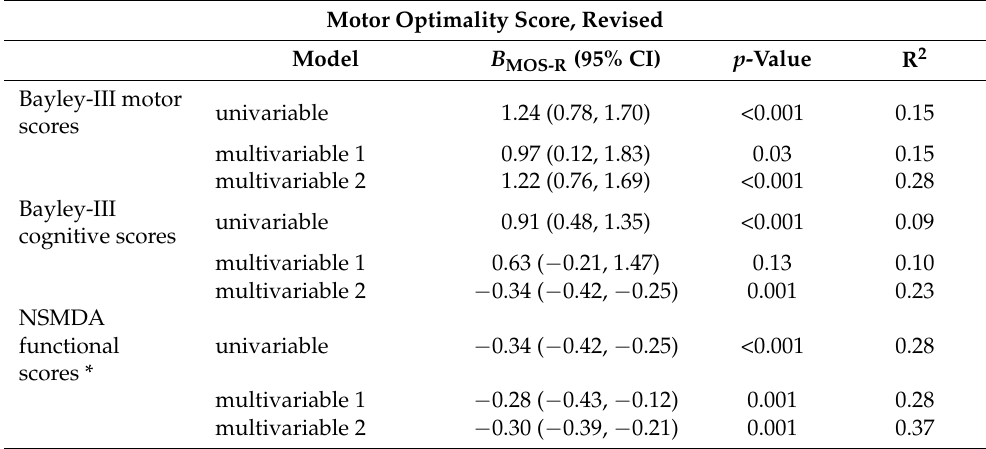
Table 2. Association between MOS-R with Bayley-III motor, cognitive scores, NSMDA functional grades and CP (definite and clinical